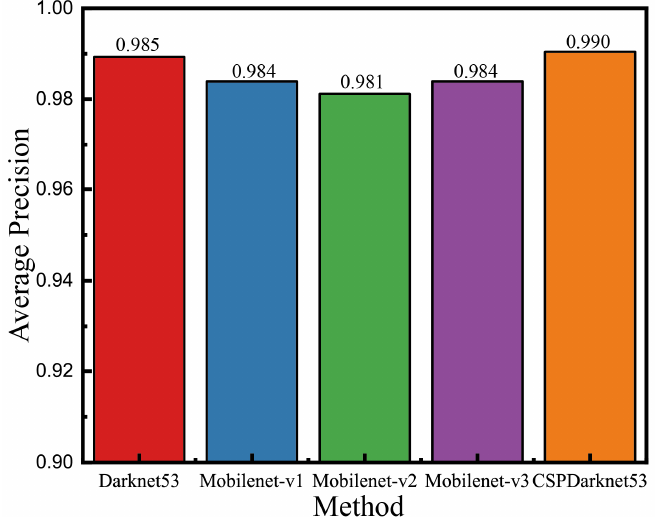
Figure 19. Comparison of the overall accuracy rate.